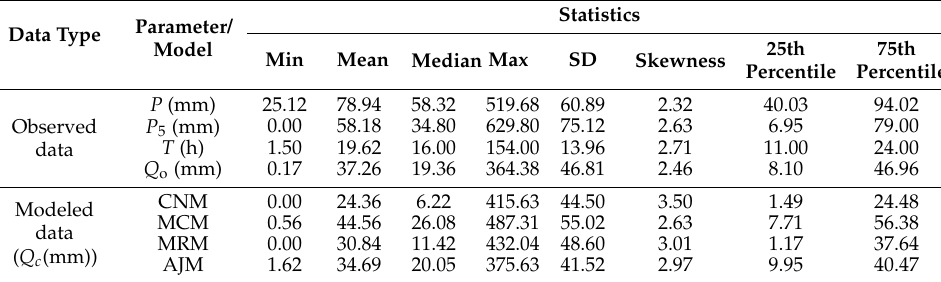
Table 2. Statistics of model outputs from the combined data set from 39